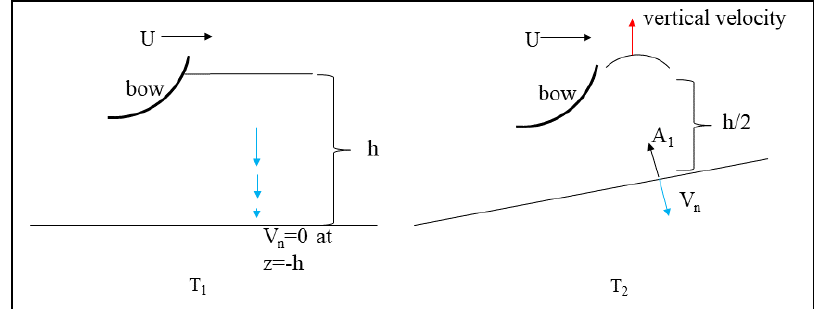
Figure 7. Ship-induced vertical velocity and wave generation at the bow. Left panel indicates time T 1 with a flat bottom. Right panel illustrates time T 2 with sloping